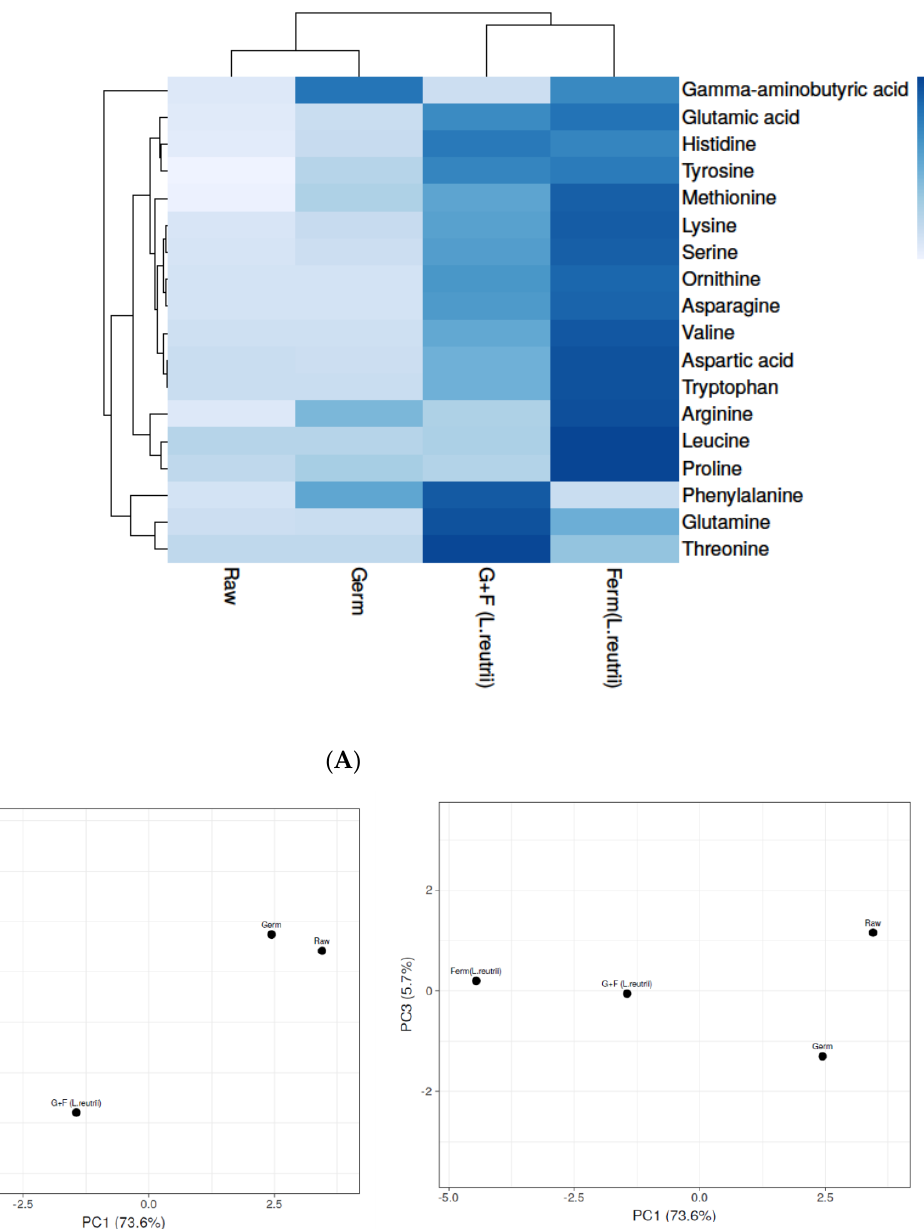
Figure 2. Levels of amino acids in raw, germinated, fermented ( L. reuterii AKT1) and G+F ( L. reuterii AKT1) samples. ( A ) The heat map shows different levels of amino acids in samples based on shades of blue. ( B ) Identification of principal component analysis (PCA) of Raw, Germ, Ferm ( L. reuterii ) and G+F samples was shown by comparing PC1 with PC2 and PC 1 with PC3. Germ-germinated brown rice, Ferm- fermented brown rice, G+F-germinated + fermented brown rice.